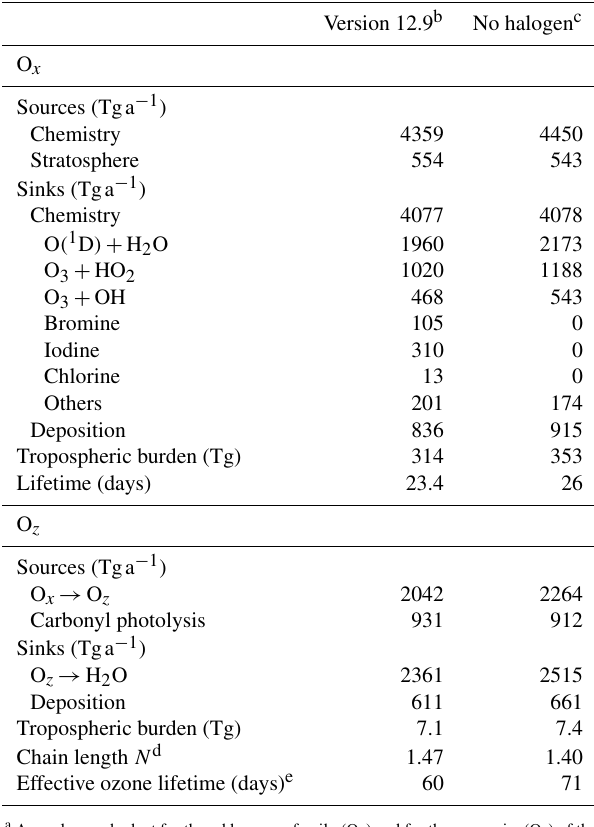
Table 5. Global tropospheric ozone budget in GEOS-Chem a